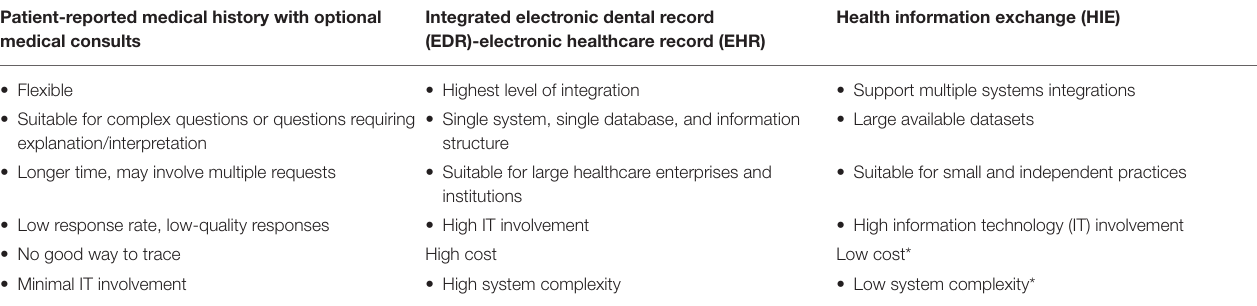
TABLE 2 | The strengths and weaknesses of the three approaches of dental clinicians accessing patient medical information identified through the modeling process. Patient-reported medical history with optional medical